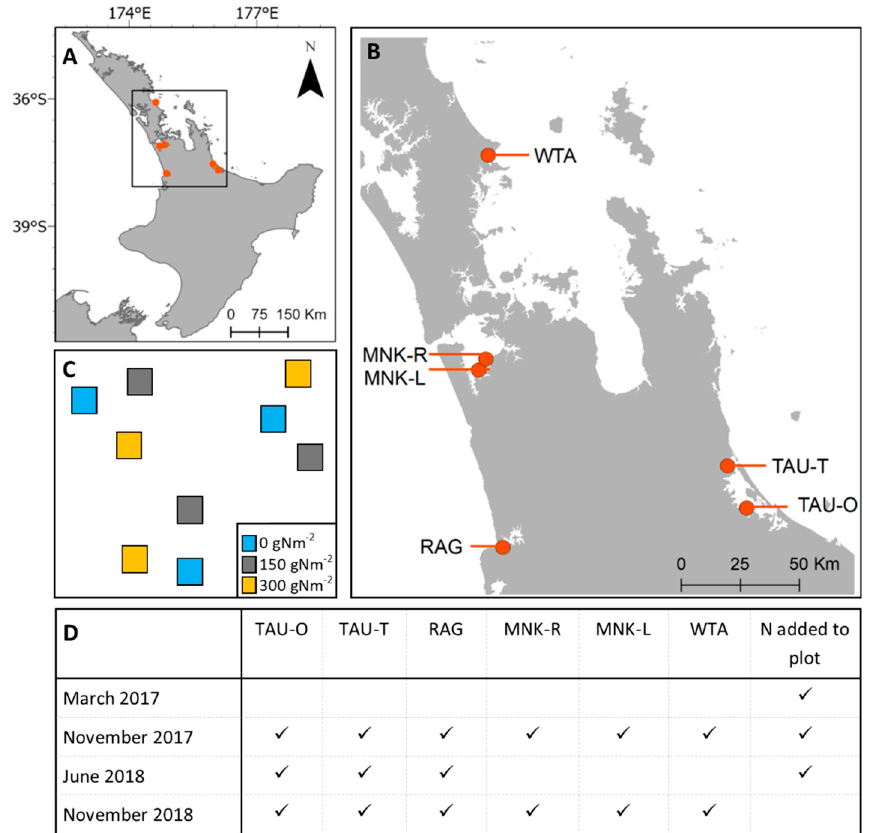
Figure 1. ( A , B ) Locations of the 6 sites, within 4 estuaries situated within the North Island of New Zealand. ( C ) Schematic of the plot layout within each site and ( D ) dates of sampling and nitrogen additions carried out after all sampling was completed.